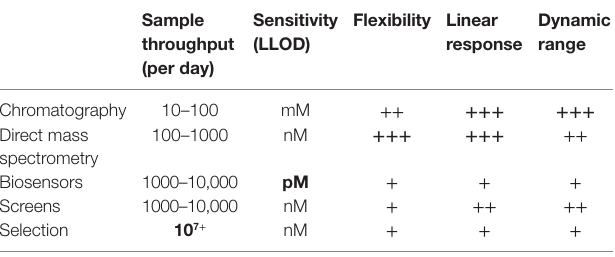
TABLe 1 | Analytical attributes of common target molecule assay types. Sample